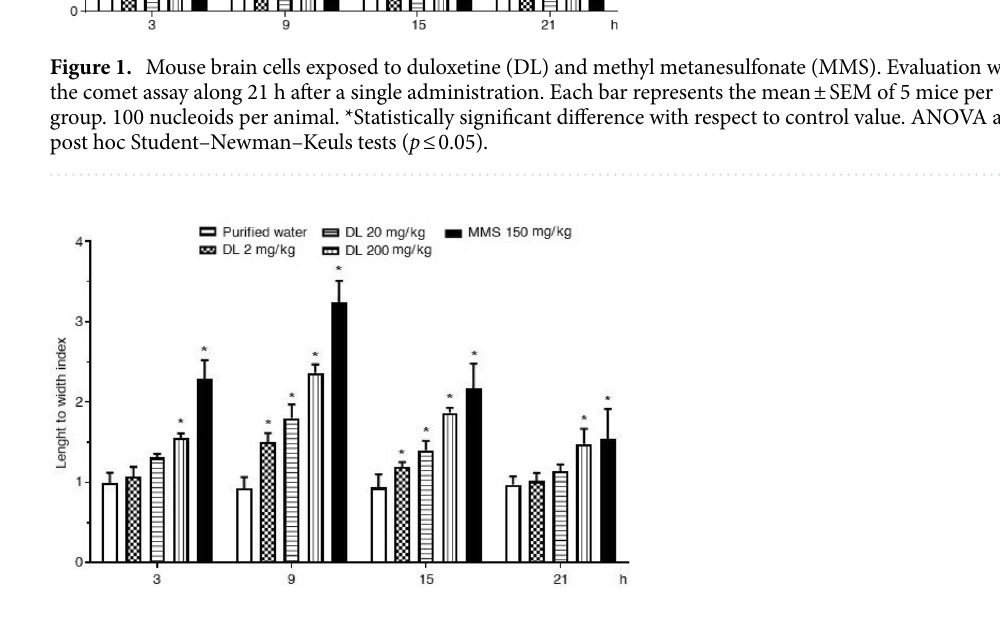
Figure 2. Mouse hepatic cells exposed to duloxetine (DL) and methyl metanesulfonate (MMS). Evaluation with the comet assay along 21 h after a single administration. Each bar represents the mean ± SEM of 5 mice per group. 100 nucleoids per animal. *Statistically significant difference with respect to control value. ANOVA and post hoc Student–Newman–Keuls tests ( p ≤